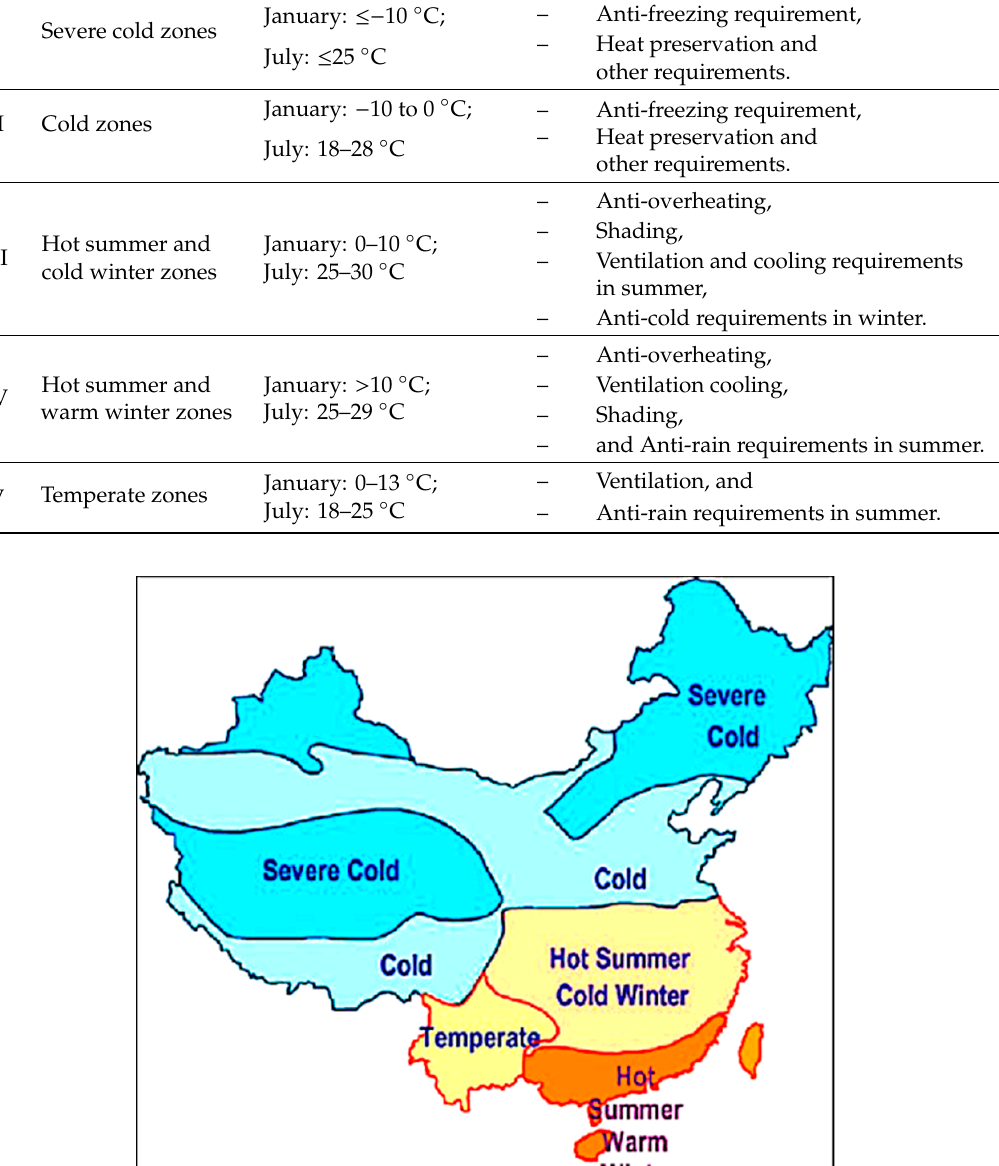
Table 2. Climate zones, characteristics and building design requirements in China [30].